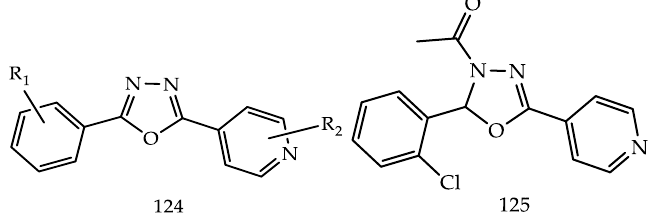
quinoline derivatives against